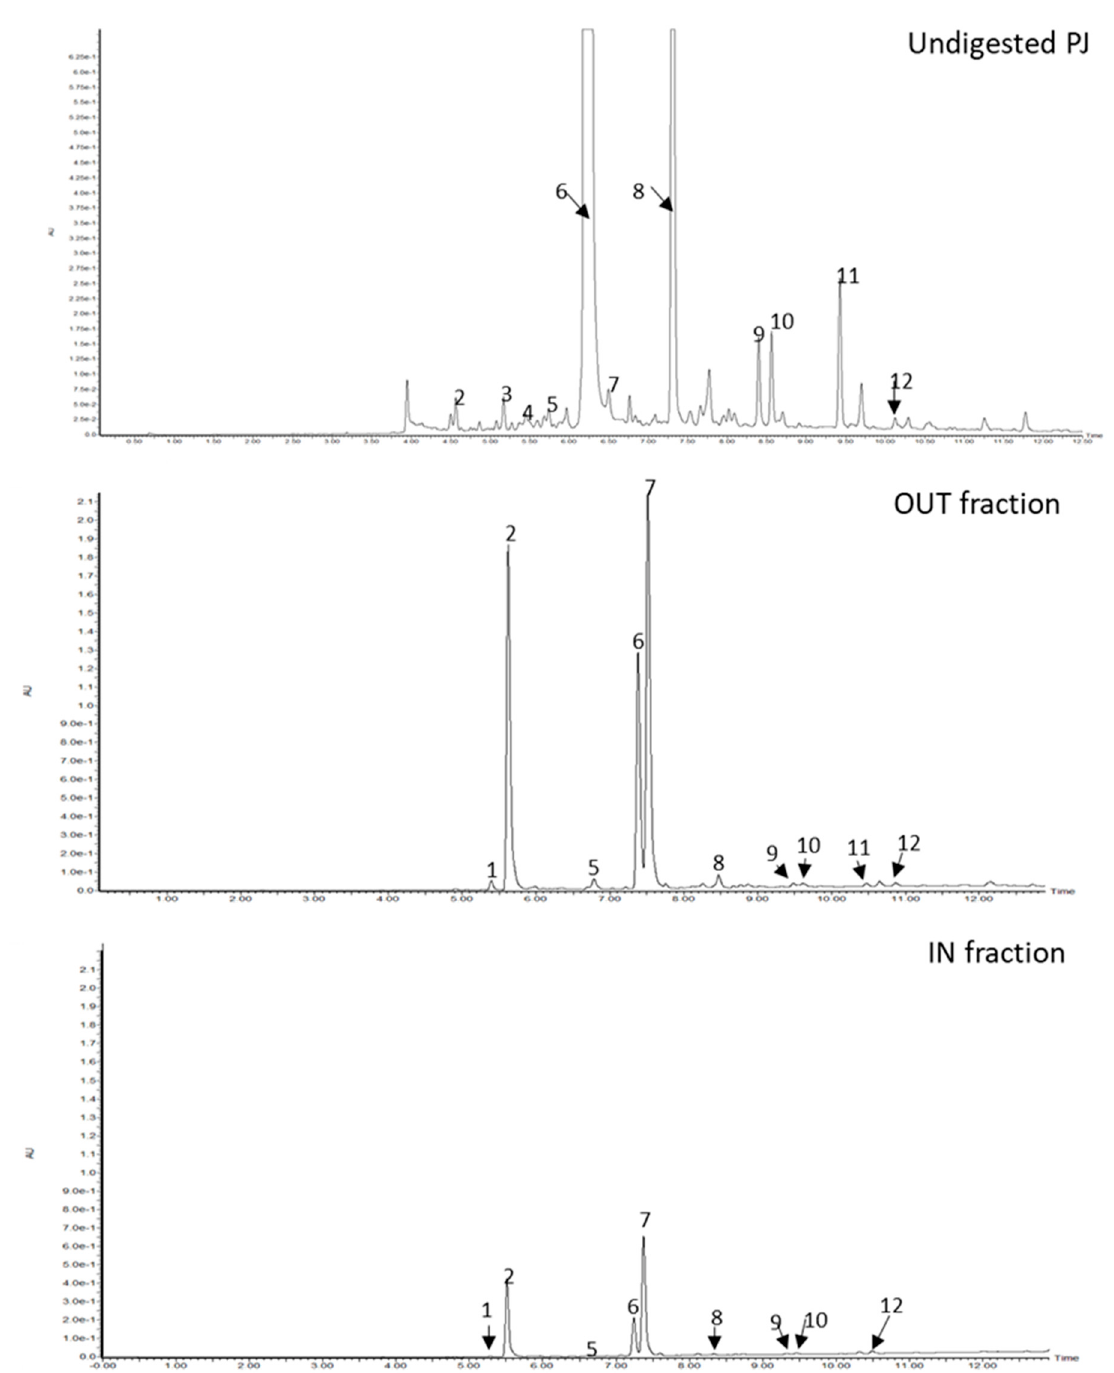
Figure 9. Chromatograms of undigested purified juice (PJ) of V. opulus fruit and after in vitro digestion process (OUT and IN fractions) registered at 320 nm. Refer to Table 1 for the identification of each numbered peak. Table 1. Quantification of individual hydroxycinnamic acids (mg/g undigested sample) in V. opulus fresh juice (FJ) and purified juice (PJ) before and after in vitro digestion.